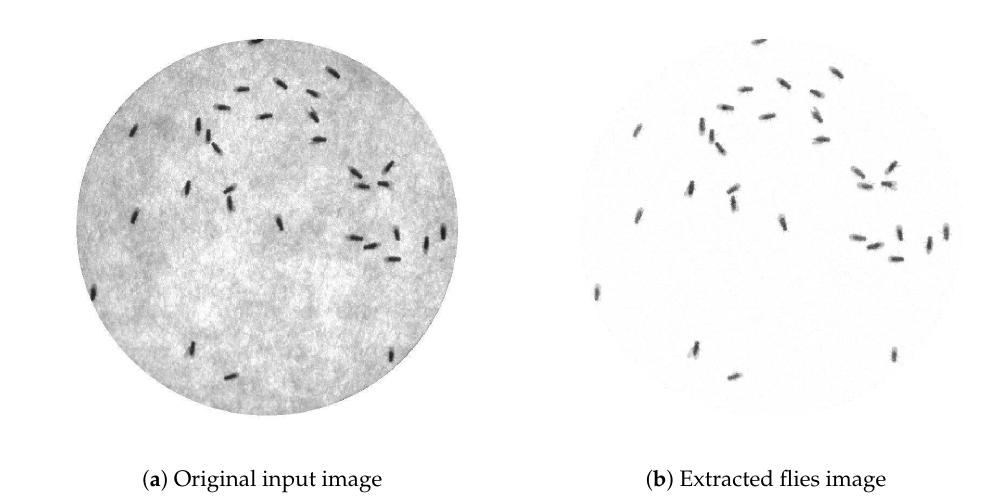
Figure 10. ( a ) Original input image and ( b ) extracted flies image from Video_1. There is a total of 32 files in a circular arena. The extracted flies image as a result of background subtraction followed by intensity